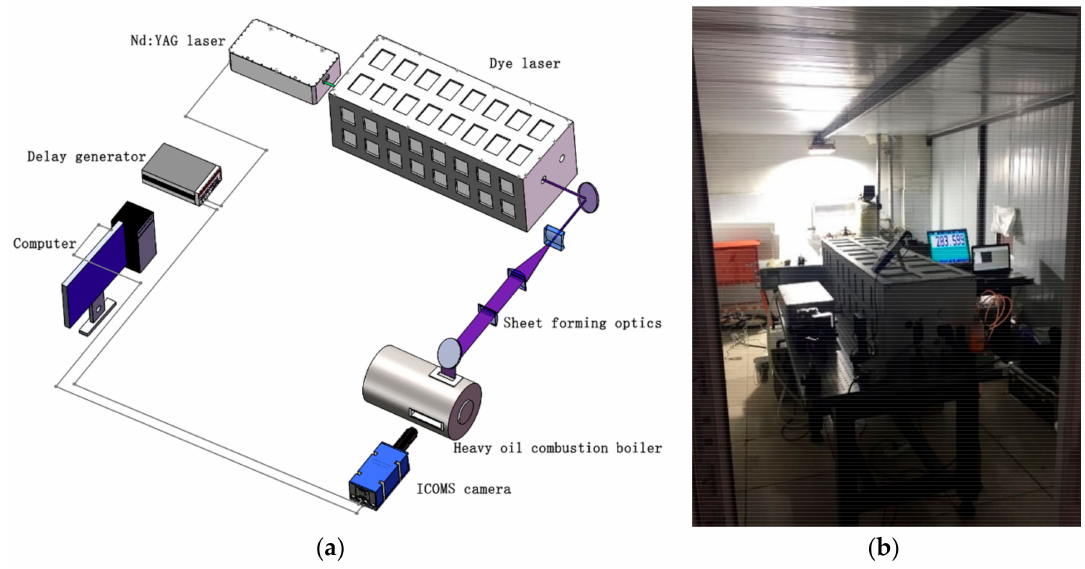
Figure 1. ( a ) Experimental set-up schematic diagram; ( b ) Experimental set-up site